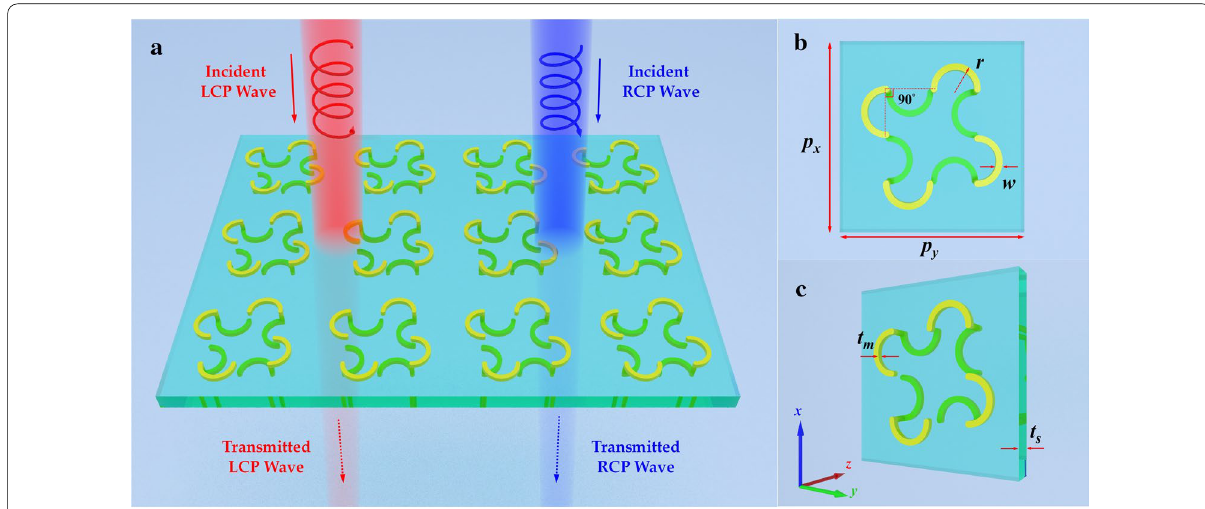
Fig. 1 Schematic of the designed CMSA: a periodic array, b , c the front and perspective view of the unit-cell nanostructure. The periodic lengths along x - and y- axis directions are both 600 nm, and the normal incident CP lights are propagating along the z -axis